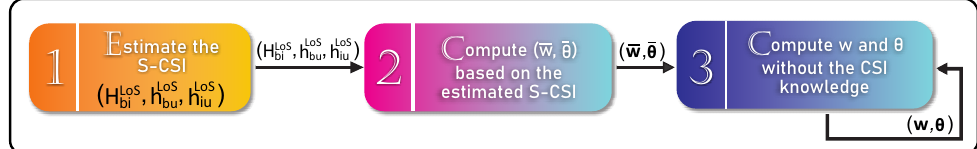
Figure 2. Diagram of the proposed